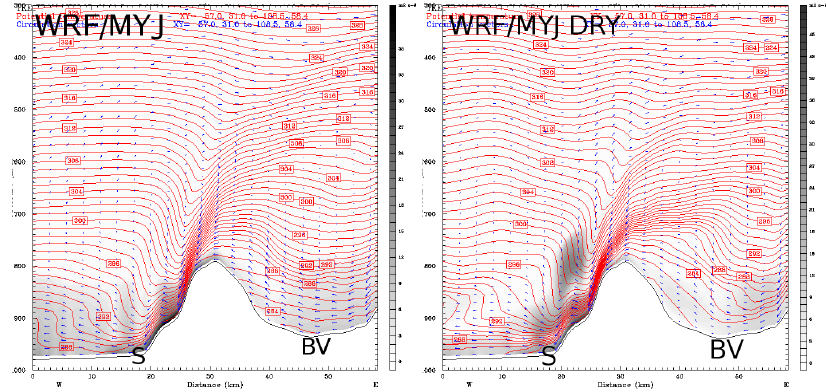
Figure 14: Cross section along line AB (cf. Fig. 4) showing potential temperature (red lines) [K], wind along the cross section (blue arrows) [ms − 1 ] and turbulent kinetic energy (TKE) [J/kg] for WRF/MYJ (left) and WRF/MYJ DRY (right) at 16 September 2004, 06:00UTC. i.e. a larger part of the mountain is above the blocked